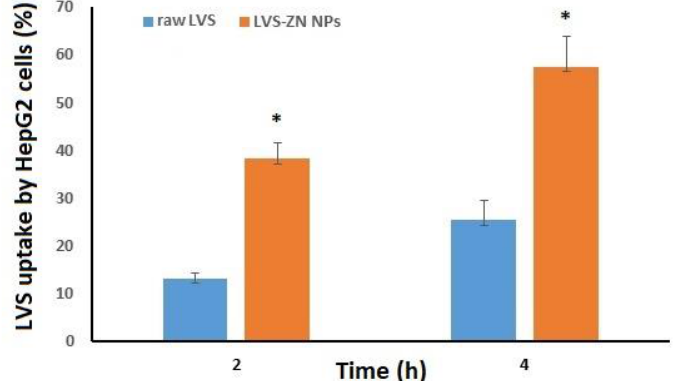
Figure 5. Uptake of LVS from the raw LVS and LVS-ZN NPs by the HepG2 cells at 2 and 4 h. * Significantly di ff erent ( p < 0.05) compared to